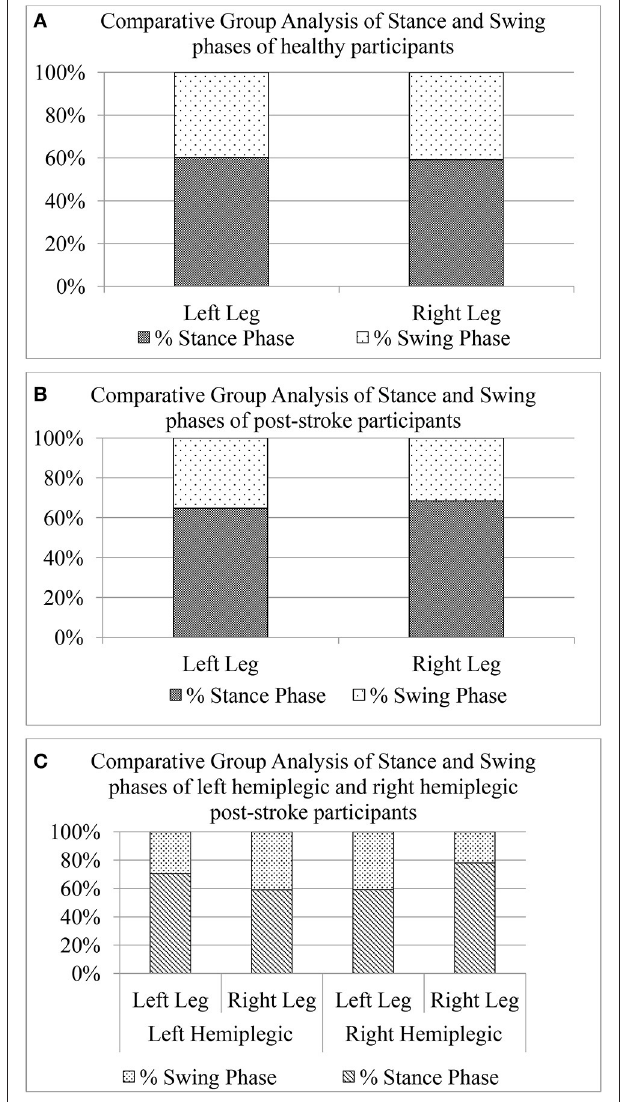
FIGURE 10 | Comparative group analysis of stance and swing stages of left and right legs for (A) Healthy participants, (B) Post-stroke participants irrespective of hemiplegic side (C) Post-stroke participants segregated into left and right hemiplegia.